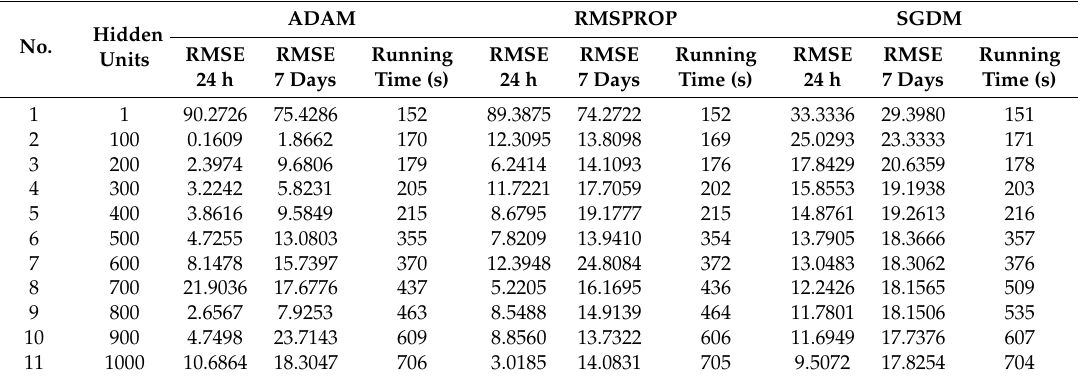
Table 1. A synthesis of the experimental results for the 20 developed long short-term memory (LSTM) artificial neural networks (ANNs) per each training